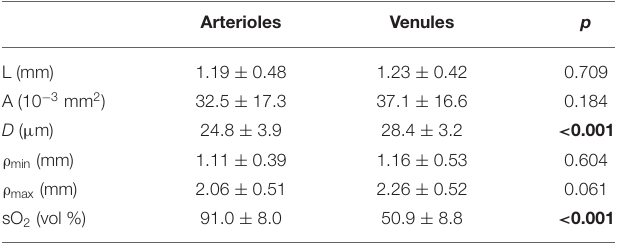
TABLE 4 | Vessel segment topographic parameters and sO 2 ( n = 57 for arterioles, n = 43 for venules). Arterioles